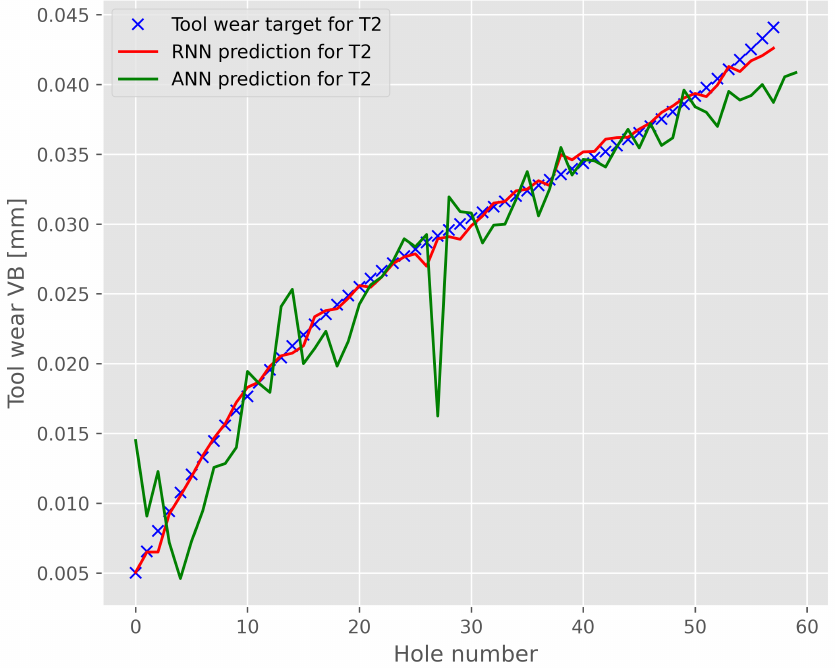
Figure 12. Comparison between RNN and ANN predictions for architecture (41, 21) and experimental tool wear target for experiment 2 with process parameters reported in Table 1. Final ANN root mean squared error (RMSE): 6.4 · 10 − 4 . RMSE RNN: 5.3 · 10 − 4